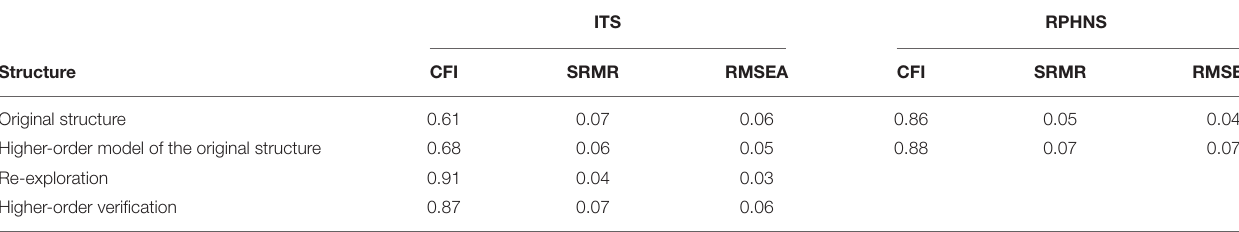
TABLE 1 | Scales’ fit indices for different structures.